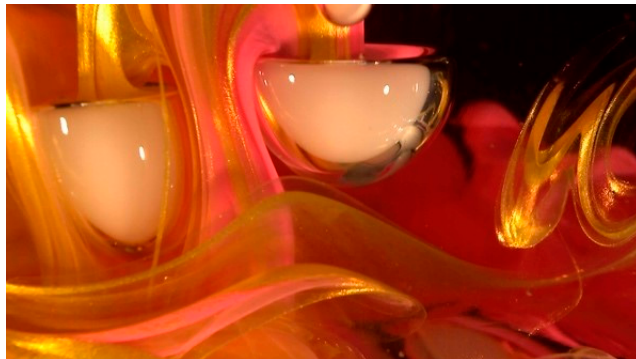
Figure 14. An example of the interaction between bubbles created by dry ice and injected color paints.